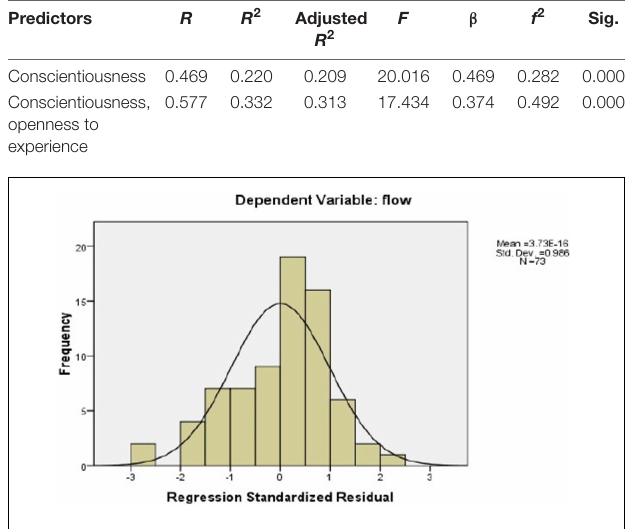
FIGURE 3 | Histogram of the